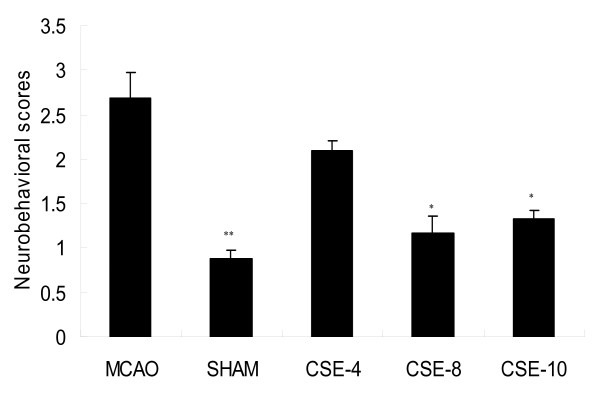
Effect of CSE on the Development of Behavioral Abnormalities after middle cerebral artery occlusion . Values are shown as means ± SEM. *p < 0.05 vs. MCAO group, **p < 0.01 vs. MCAO group. (FSHAM = 17.642, dfSHAM = 11, pSHAM = 0.001, F CSE-4 = 2.252, df CSE-4 = 11, p CSE-4 = 0.162, F CSE-8 = 16.396, df CSE-8 = 11, p CSE-8 = 0.01, F CSE-10 = 22.738, dfSHAM = 11, pSHAM = 0.02)